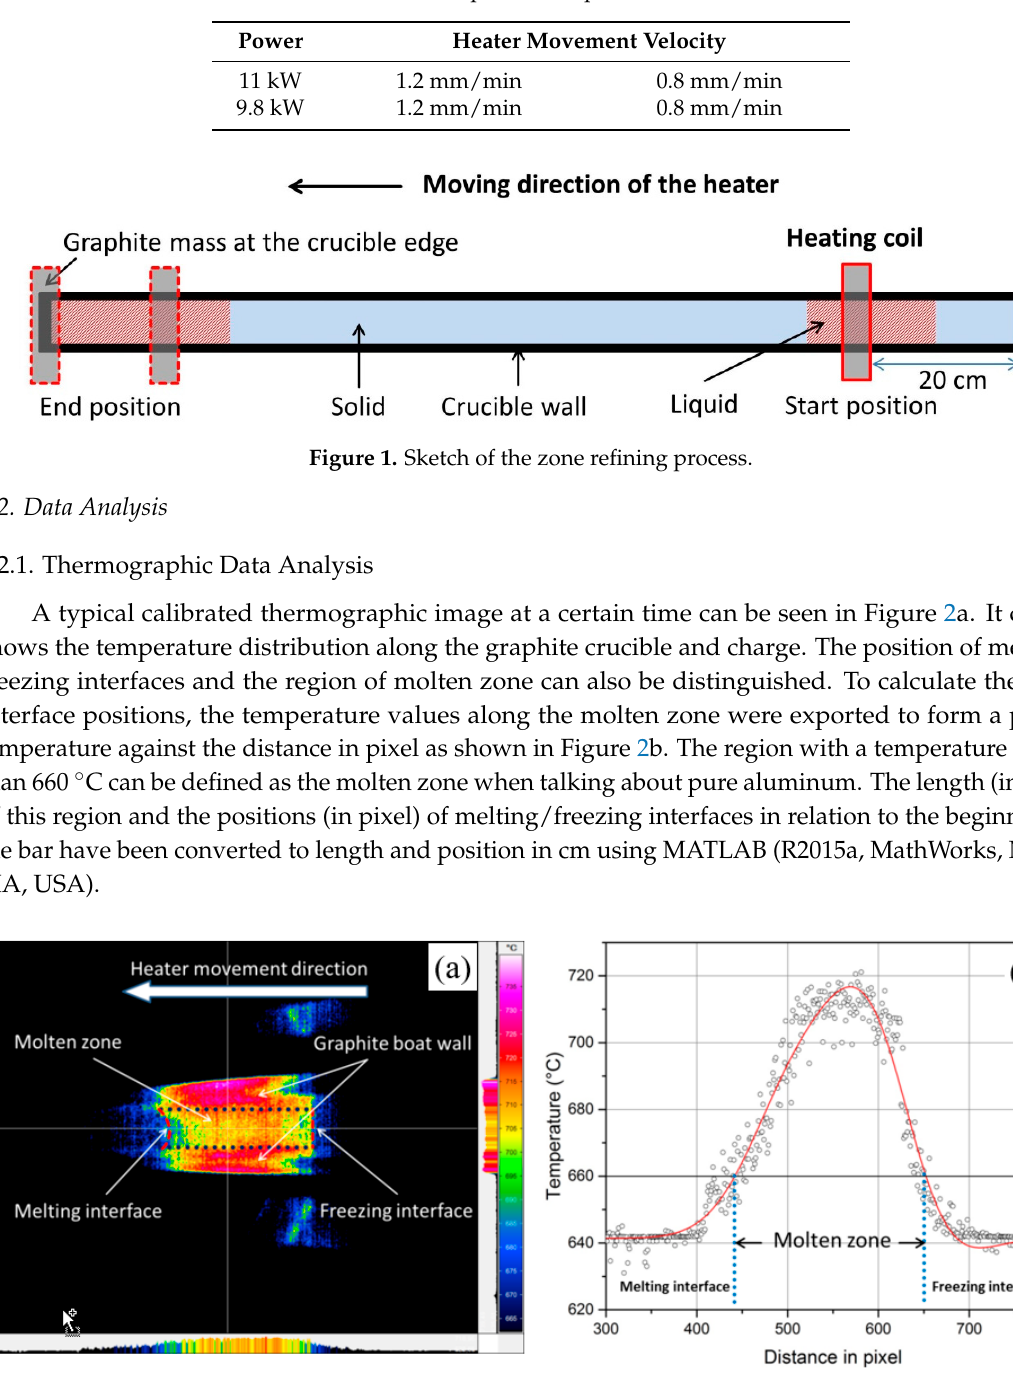
Figure 2. An exemplary thermographic image in zone refining of aluminum ( a ) and the corresponding temperature distribution profile in the molten zone along the bar ( b ).